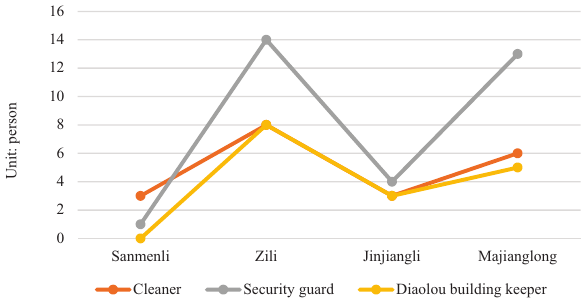
Figure 7. Number of service workers in the four core areas (source: field